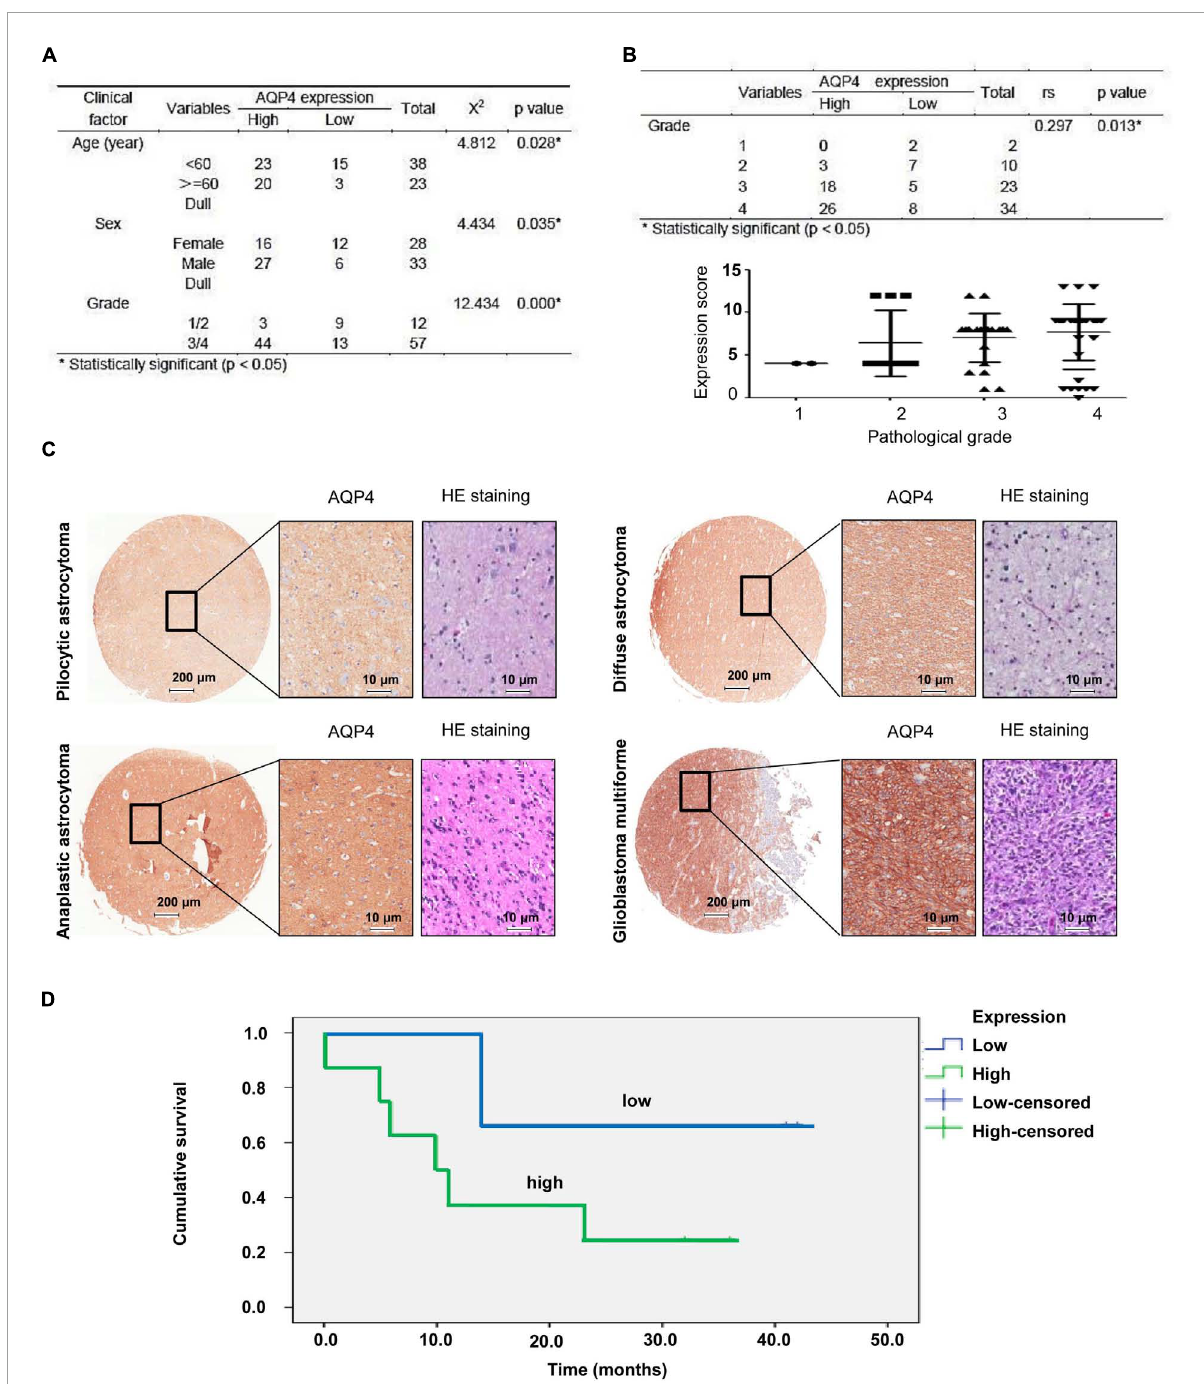
FIGURE1 Clinical data analysis of AQP4 expression in human tissue microarrays from glioma patients. (A) Correlation analyses of AQP4 protein expression in relation to clinicopathologic variables of 77 glioma patients by a X 2 test. (B) Quantitative analysis of the relative AQP4 expression level in all groups was performed. Furthermore, the correlation between AQP4 expression and different glioma grades was also assessed by Spearman’s rank correlation analysis. (C) Representative images of immunohistochemical staining to assess AQP4 protein levels in the glioma tissue microarray. (D) Kaplan-Meier analysis of OS for glioma cancer patients with different expression levels of AQP4 by a log-rank test. “Low” indicates a low level of AQP4 expression; “high” indicates a high level of AQP4